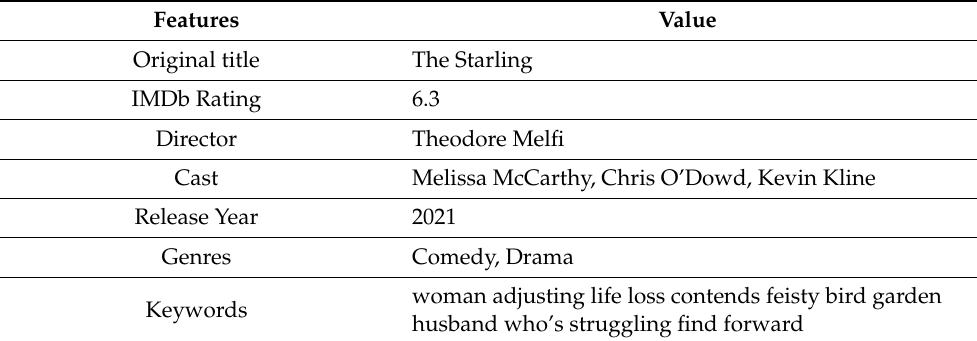
Table 2. Example of movie features extracted.